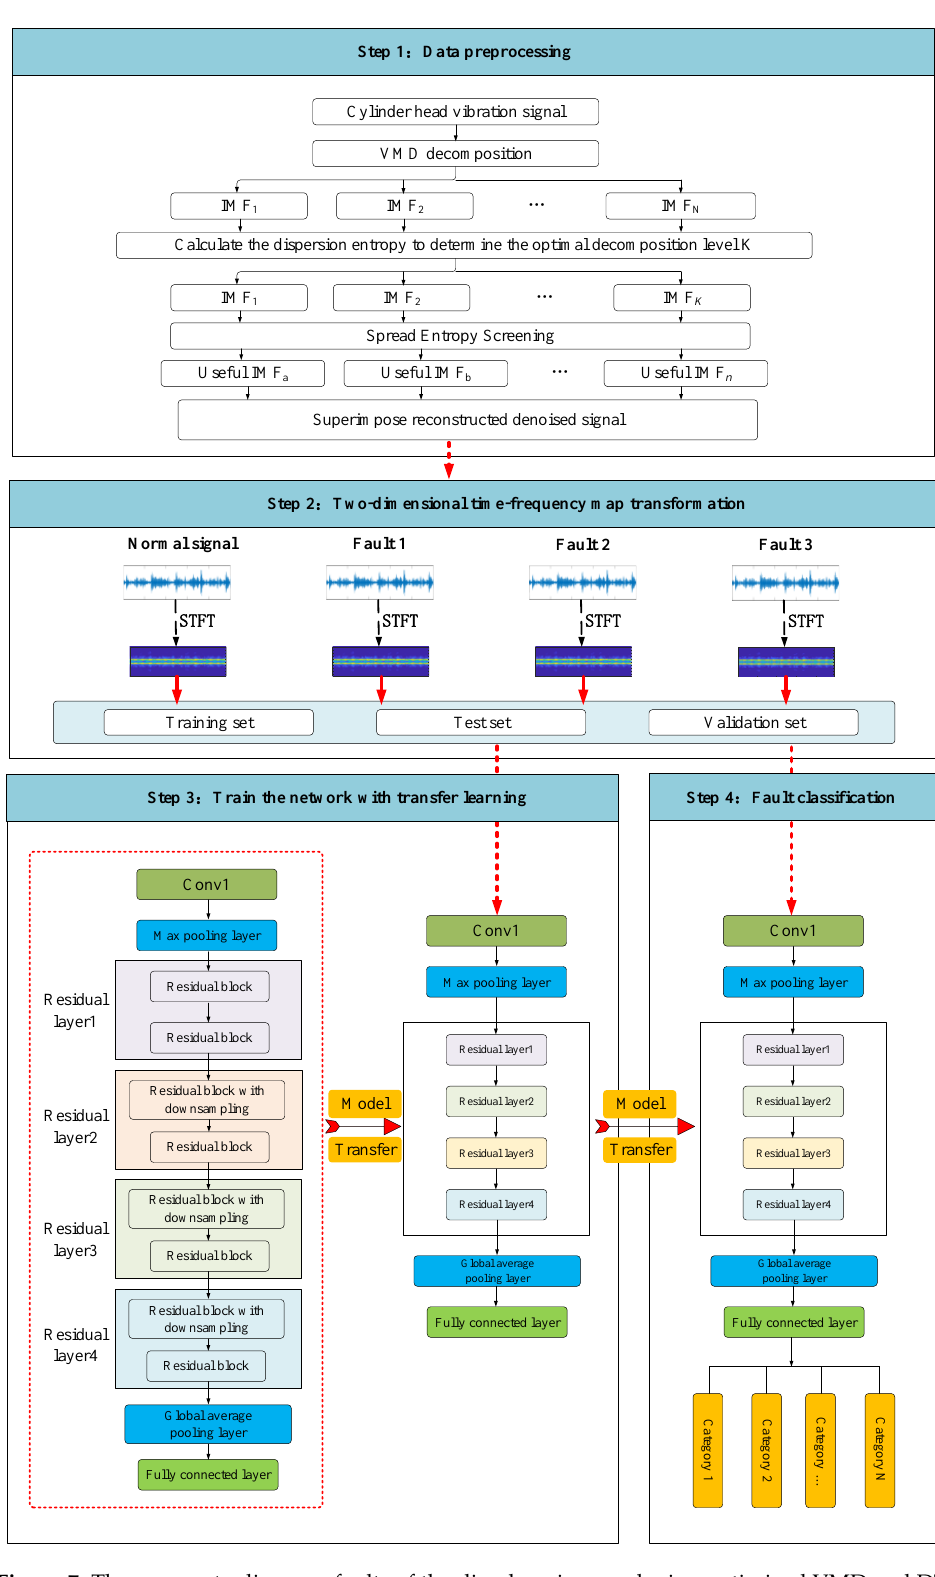
Figure 7. The process to diagnose faults of the diesel engine employing optimized VMD and DTL.